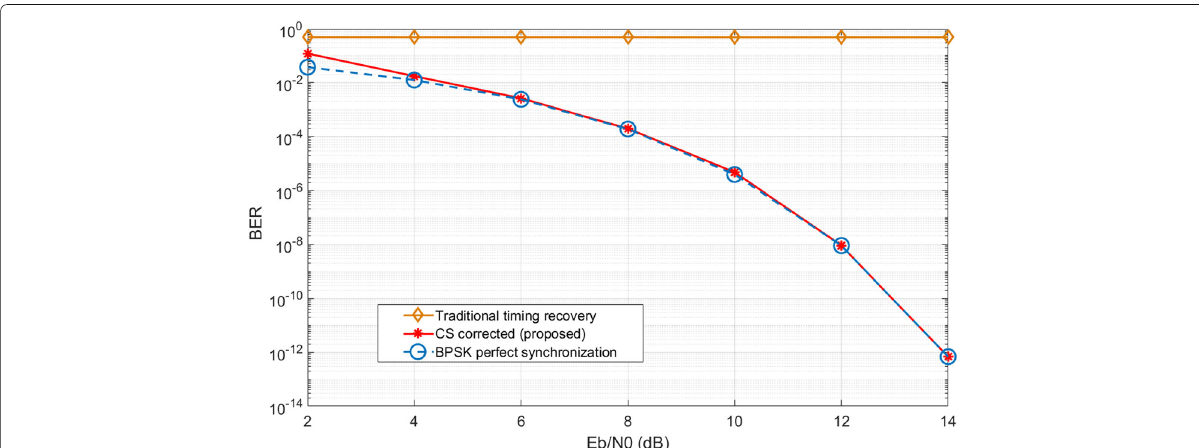
Fig. 7 BER performance of demodulation of BPSK modulated burst signal, N = 300, N (cid:2) = 4096, η = 0.1